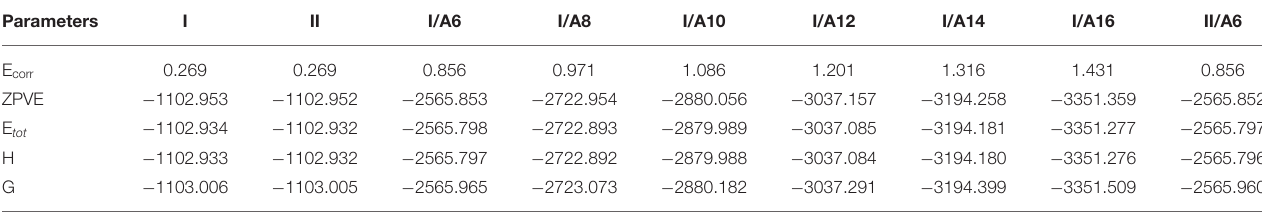
TABLE 2 | Thermal parameters (Hartree/Particle) of both conformers of the H -bonded complexes I/A n and II/A 6 . Parameters